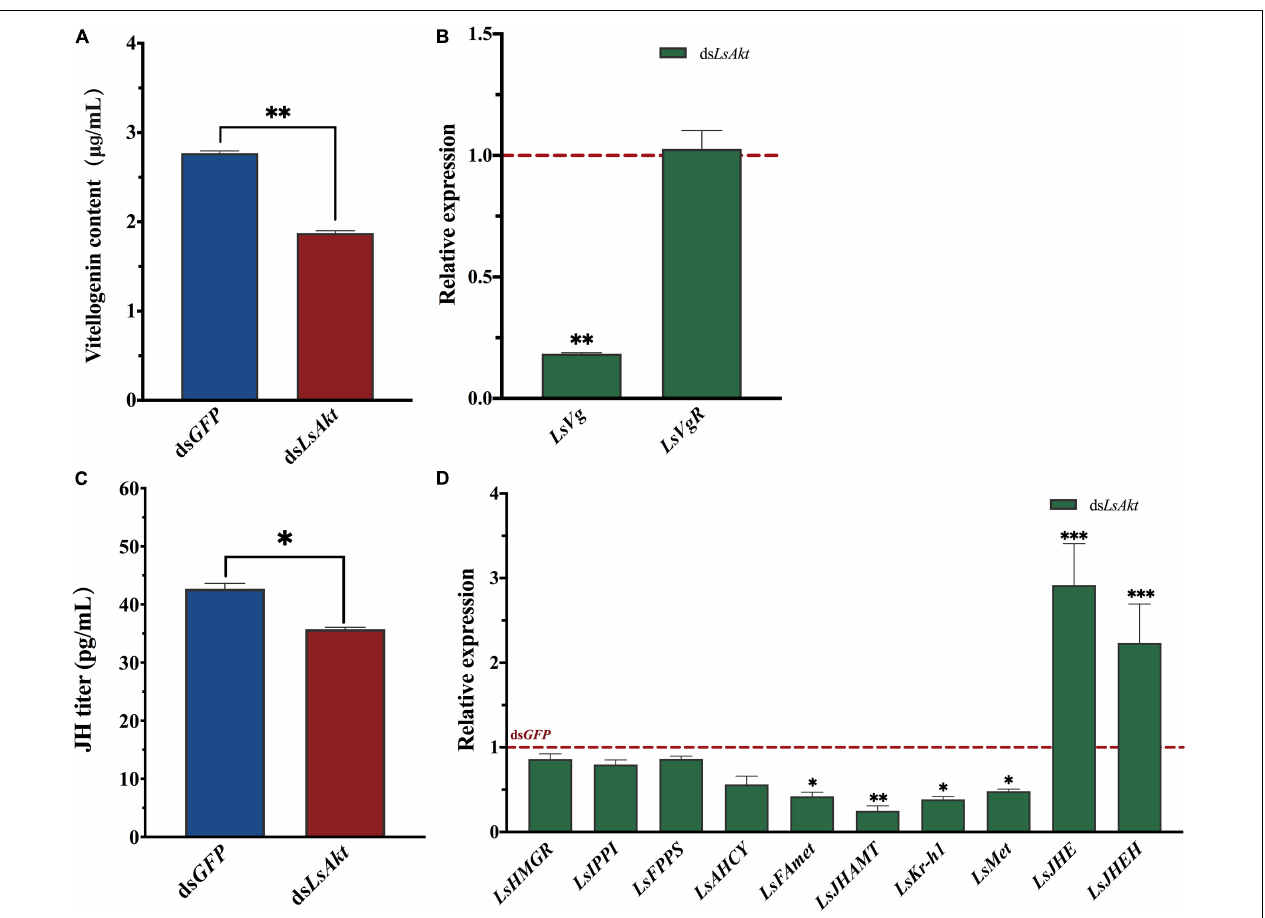
FIGURE 5 | Effect of LsAkt RNAi on vitellogenin synthesis and juvenile hormone signaling. (A) Vitellogenin content in female adults after LsAkt knockdown. (B) Relative expression of Vg and VgR after RNAi. (C) JH tiers in female adults after LsAkt knockdown. (D) Relative expression of juvenile hormone signaling pathway genes after RNAi. The expression values were calculated by comparison to the ds GFP group, which was normalized at 1. Significant differences between the RNAi group and control group were determined using Student’s t -test ( ∗ P < 0.05, ∗∗ P < 0.01, ∗∗∗ P <